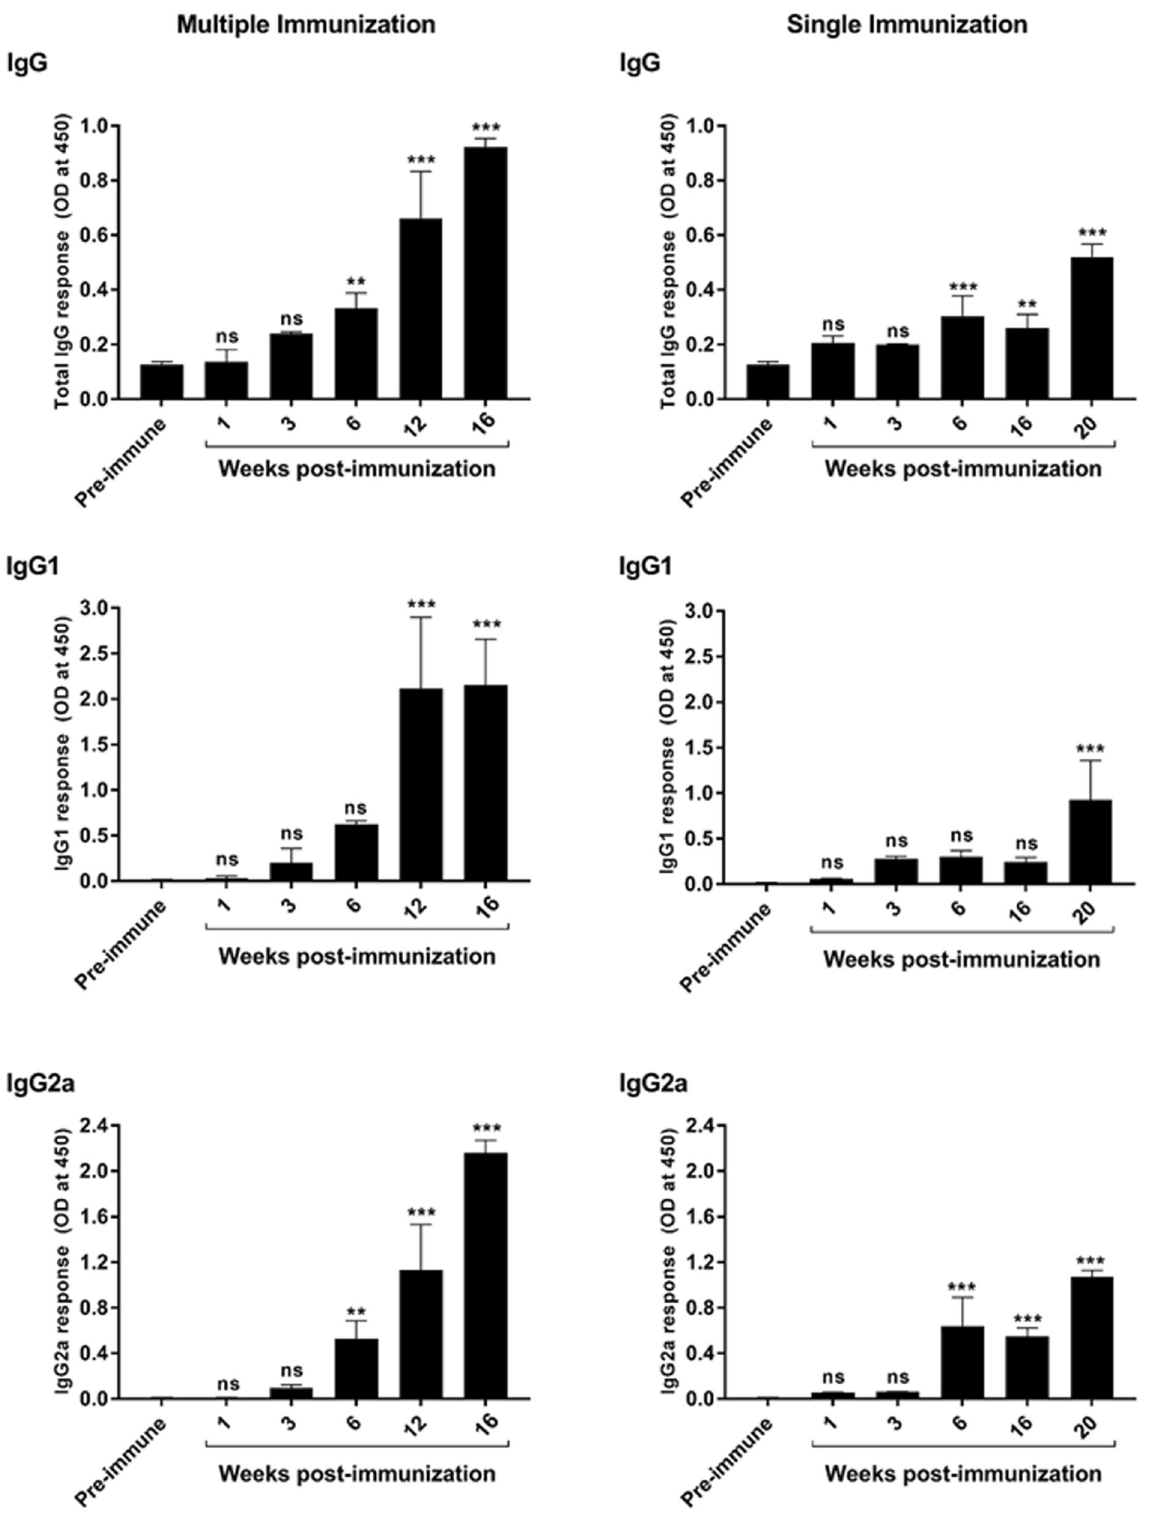
Fig. 5 Induction of T. cruzi -speci fi c B-cell responses by DKO parasites. Anti- T. cruzi total IgG, IgG1, and IgG2a levels after repeated administration of DKO culture-derived metacyclic trypomastigotes in immuno-competent mice (left panels) and also in animals which underwent single DKO inoculation (right panels). Total WT parasite lysates were used as antigen to test serum antibodies using ELISA. Sera were compared using 1:100 dilution. N = 5 for each analysis and the mean values and SD are shown for each. One-way ANOVA using Dunnett ’ s post test was used and P values are: **<0.01,